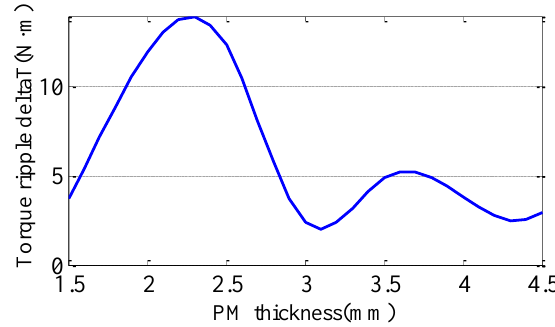
Figure 8. Output torque ripple curves with different PM thickness l 4 .